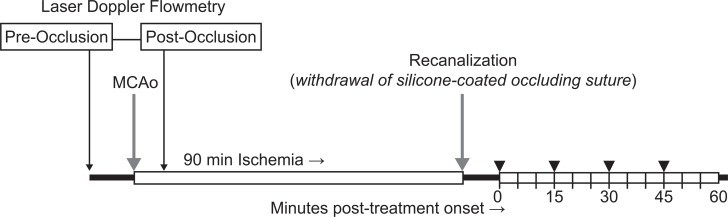
Experimental timeline.Microbubble enhanced sonothrombolysis was tested in a model of 90 minute MCA occlusion. Regional cerebral blood flow (rCBF) was measured by laser doppler flowmetry to confirm successful occlusion (post-occlusion). Randomization to treatment group occurred post-recanalization and immediately pre-treatment onset. rt-PA was administered every 5 minutes (dashed lines) in all treatment animals. Microbubbles (SonoVue or BR38) were administered at 15 minute intervals (▼). Control and rt-PA treatment groups received equal volumes of saline for rt-PA and microbubbles. Continuous ultrasound was applied for 60 minutes in conjunction with rt-PA and microbubble infusion.